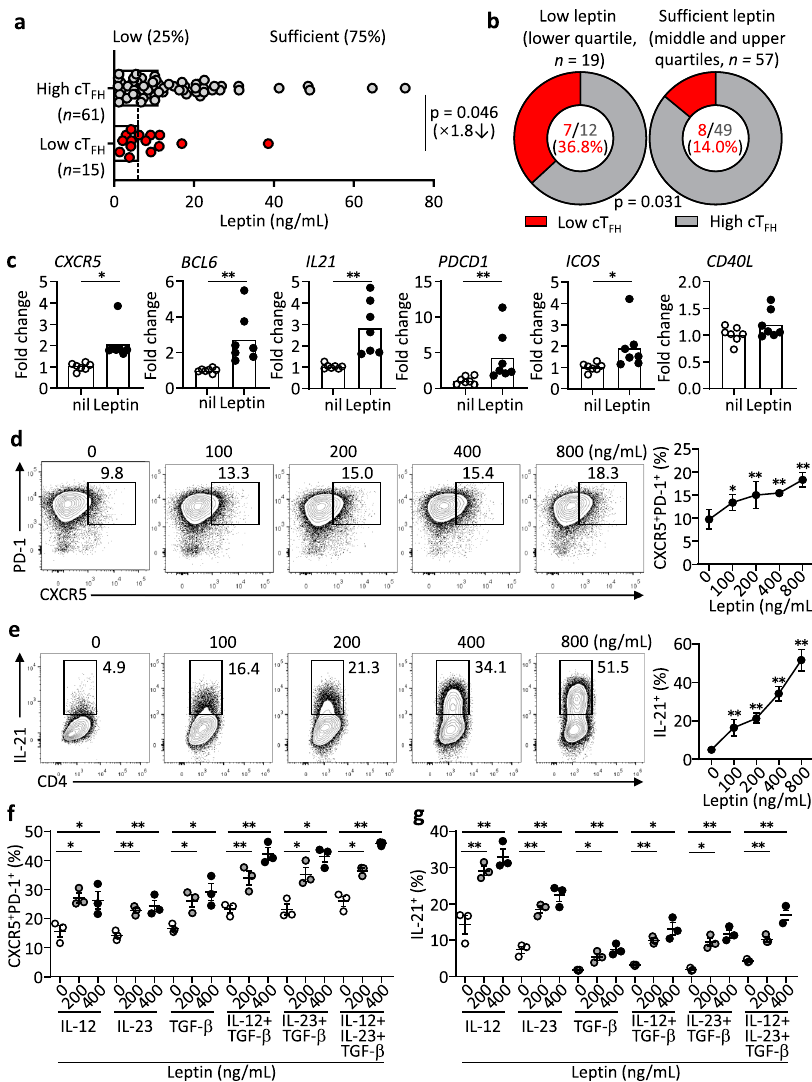
Fig. 2 Leptin potentiates the differentiation and function of human T FH cells. a Comparison of serum leptin levels between healthy individuals with T FH increase (fold changes of T FH cells, the ratio of day 7/day 0 > 1) ( n = 61, grey) and healthy individuals without T FH increase (fold changes of T FH cells, the ratio of day 7/day 0 ≤ 1) ( n = 15, red) in healthy adults (18 – 60 years, n = 76) immunized with the in fl uenza vaccine (Supplementary Table 4). Dotted line indicates healthy individuals with low leptin levels (lower 25%) and suf fi cient leptin levels (higher 75%). b Comparison of T FH changes and vaccine response in low leptin group ( n = 19) and suf fi cient leptin group ( n = 57). c Real-time PCR analysis of T FH -related genes in naïve CD4 + T cells from PBMC of healthy controls with anti-CD3/CD28 activation for 3 days, and further treated with leptin for 12 h ( CXCR5 : * P = 0.0176, Bcl6 : ** P = 0.0046, IL21 : ** P = 0.0085, PDCD1 : ** P = 0.0050, ICOS : ** P = 0.0344) ( n = 7). d , e Representative FACS plots and statistics showing the differentiation of CXCR5 + PD-1 + T FH cells ( d ) (100 ng/mL: * P = 0.0257, 200 ng/mL: ** P = 0.0012, 400 ng/mL: ** P = 0.0005, 800 ng/mL: ** P < 0.0001), and the secretion of IL-21 ( e ) (100 ng/mL: ** P = 0.0004, 200 ng/mL: ** P < 0.0001, 400 ng/mL: ** P < 0.0001, 800 ng/mL: ** P < 0.0001) from puri fi ed human naïve CD4 + T cells stimulated with anti-CD3/CD28 and indicated concentrations of leptin for 4 days (dots, n = 5; bars, mean ± SEM). f , g Statistics showing the percentages of CXCR5 + PD-1 + T P = 0.0105, * P = 0.0107; IL-23: ** P = 0.0063, ** P = 0.0087; TGF- β : * P = 0.0187,* P = 0.0161; IL-12 + TGF- β : ** P = 0.0063,** P FH cells ( f ) (IL-12: * = 0.0052; IL-23 + TGF- β : * P = 0.0452,* P = 0.0211; IL-12 + IL-23 + TGF- β : * P = 0.0206,** P = 0.0023) and IL-21 + cells ( g ) (IL-12: ** P = 0.0068, ** P = 0.0071; IL-23: ** P < 0.0001, ** P = 0.0012; TGF- β : * P = 0.0287,** P = 0.0096; IL-12 + TGF- β : ** P = 0.0023,* P = 0.0129; IL-23 + TGF- β : * P = 0.0145,** P = 0.0044; IL-12 + IL-23 + TGF- β : ** P = 0.0084,** P = 0.0082) differentiated from naïve CD4 + T cells with anti-CD3/CD28 stimulation and indicated cytokine combinations for 4 days (dots, n = 5; bars, mean ± SEM). Data from individuals (dots) and the median values (bars) are shown for ( a ); Mann – Whitney test was used for analysis ( a ). Percentages and numbers are shown for ( b ); Chi-Square test was used for analysis ( b ). Real-time PCR and FACS statistics are shown for individuals (dots, n = 3) and mean ± SEM (bars) values, and analysed by Mann – Whitney U-test ( a , c ), one-way ANOVA Dunnett ’ s multiple comparisons test ( d – g ). * P < 0.05, ** P < 0.01. Results are representative of three independent clearance (Fig. 3a, Supplementary Fig. 4a). Despite the increased cytometric analysis revealed a signi fi cant reduction of T FH cells viral antigens, db/db mice produced signi fi cantly less virus- (Fig. 3d), accompanied by the decrease in germinal centre (GC) B speci fi c antibodies in sera and bronchoalveolar lavage fl uid cells and antibody-secreting cells (ASCs) (Fig. 3e, f) in the (BALF) (Fig. 3b, c). Draining lymph node is important for mediastinal lymph nodes (mLNs). An Enzyme-Linked Immuno- memory T FH formation and vaccination ef fi cacy 30 , fl ow Spot (ELISPOT) assay also showed a two-fold reduction of ASCs